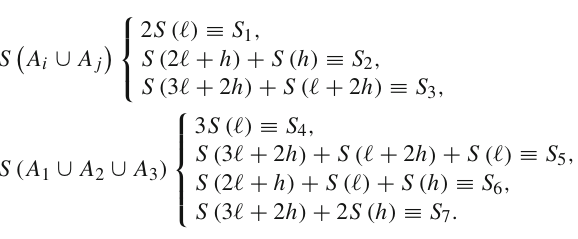
Fig. 4 Schematic representation of competing configurations in the computation of S ( A i ∪ A j ) and S ( A 1 ∪ A 2 ∪ A 3